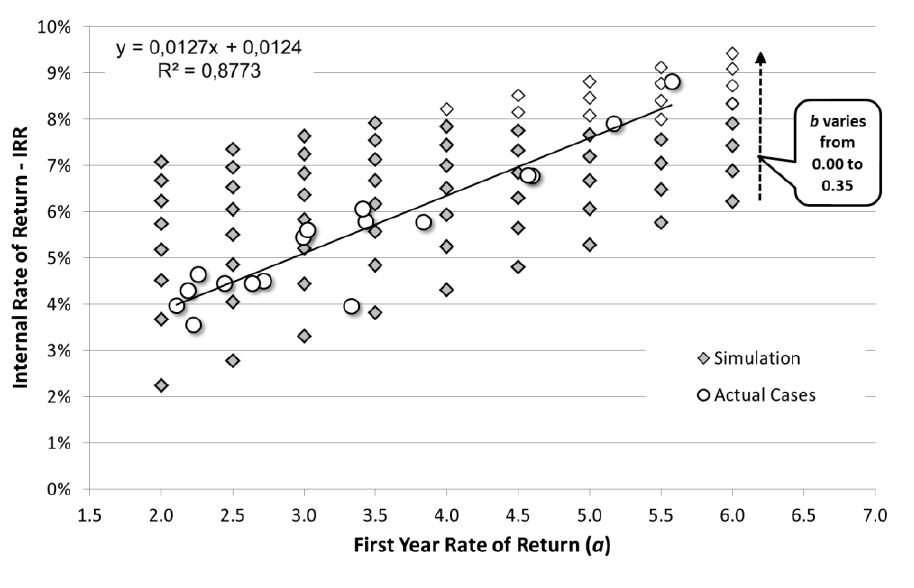
Figure 4. Influence of the variables a and b on the projects’ IRR (C*=100 -